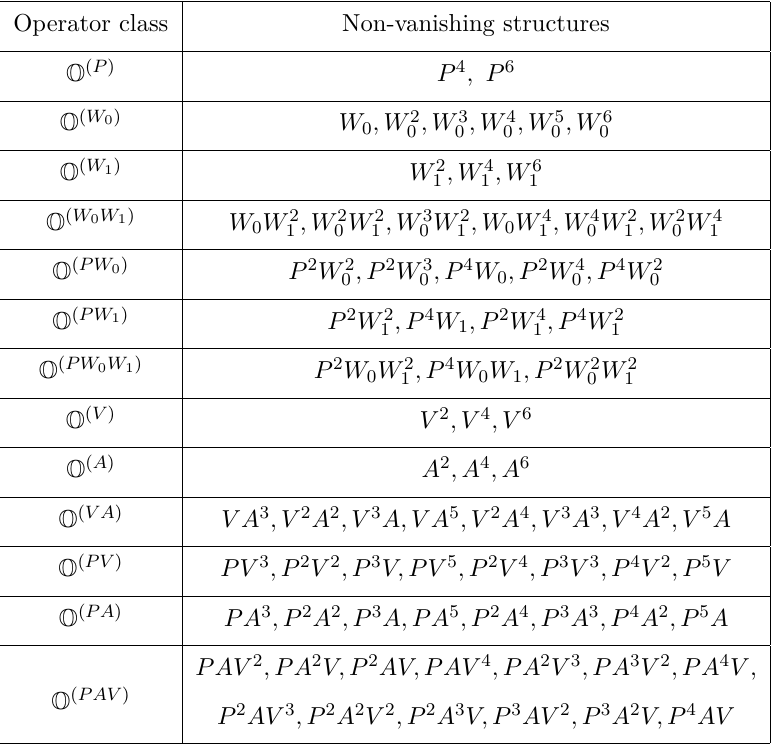
Table 2 . Non-vanishing operator structures in the fermionic UOLEA that involve covariant deriva- tives ( P ) plus either scalar and pseudo-scalar structures ( W 0 , W 1 ), or vector and axial-vector struc- tures ( V, A